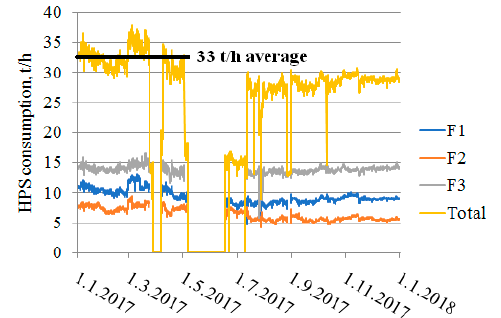
Figure 5. HPS steam consumption, calculated to cover the process heat duty currently covered by furnaces F1 to F3.